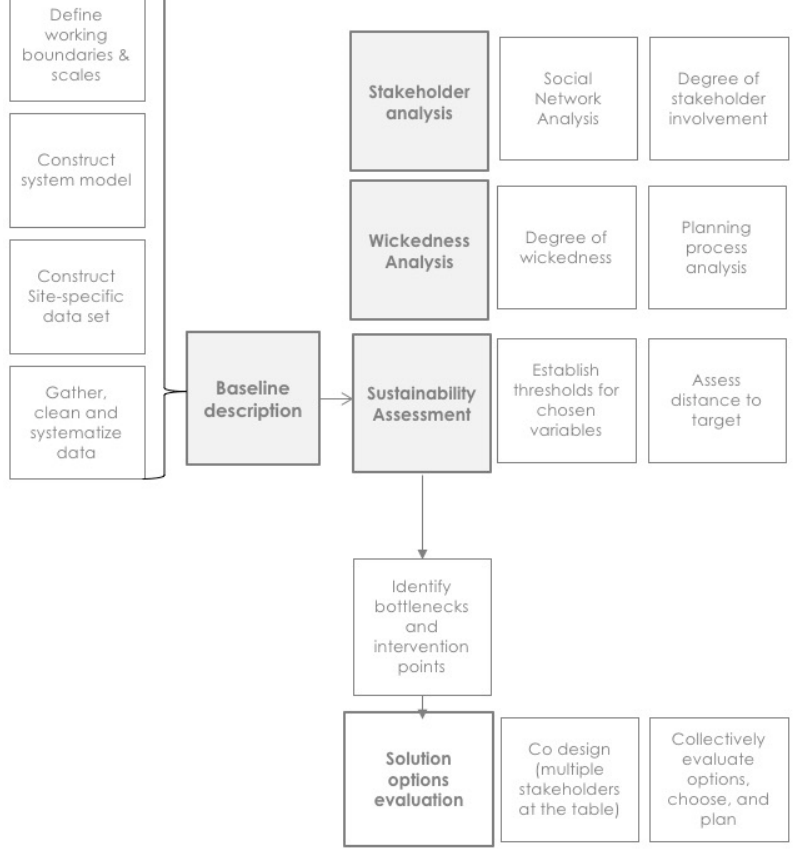
Figure 1. The general method used in this research project. Highlighted blocks are the four building blocks in our method. This paper deals in detail with two blocks: Baseline Description and Sustainability